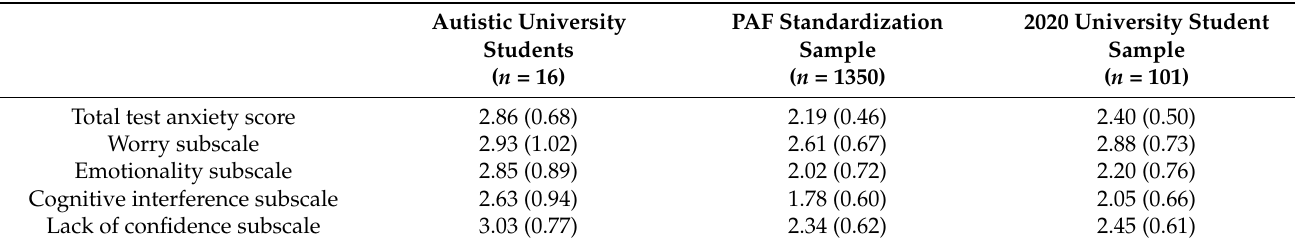
Table 1. Means and Standard Deviations (in brackets) of Test Anxiety Scores in the Autistic University Student Sample, the PAF Standardization Sample [14], and the Close-to-Examination Non-autistic University Student Sample (January